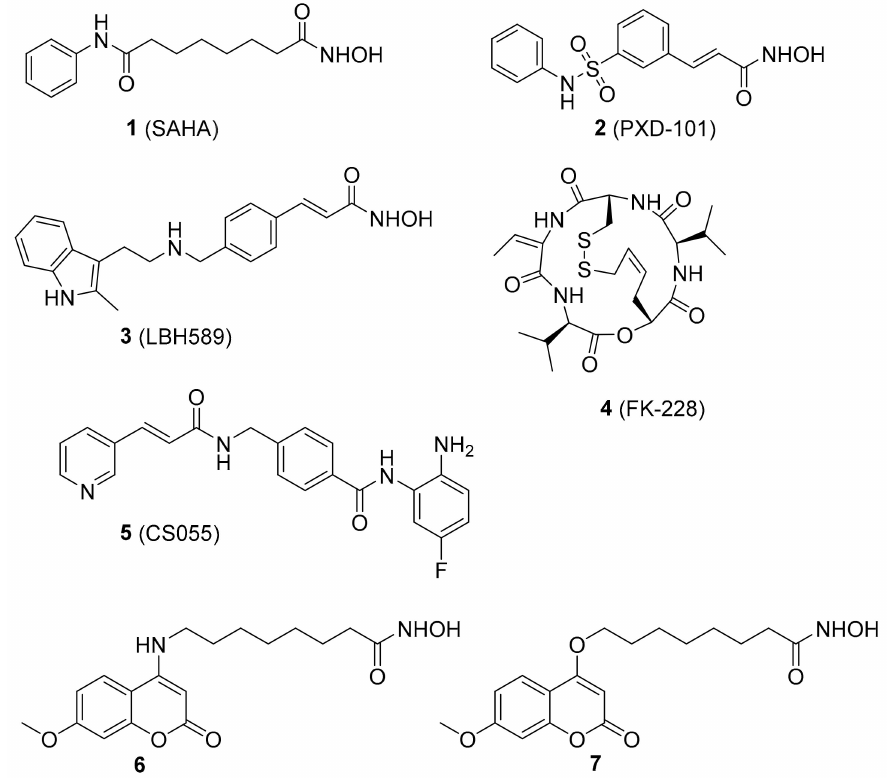
Figure 1. Chemical structures of representative histone deacetylase inhibitors